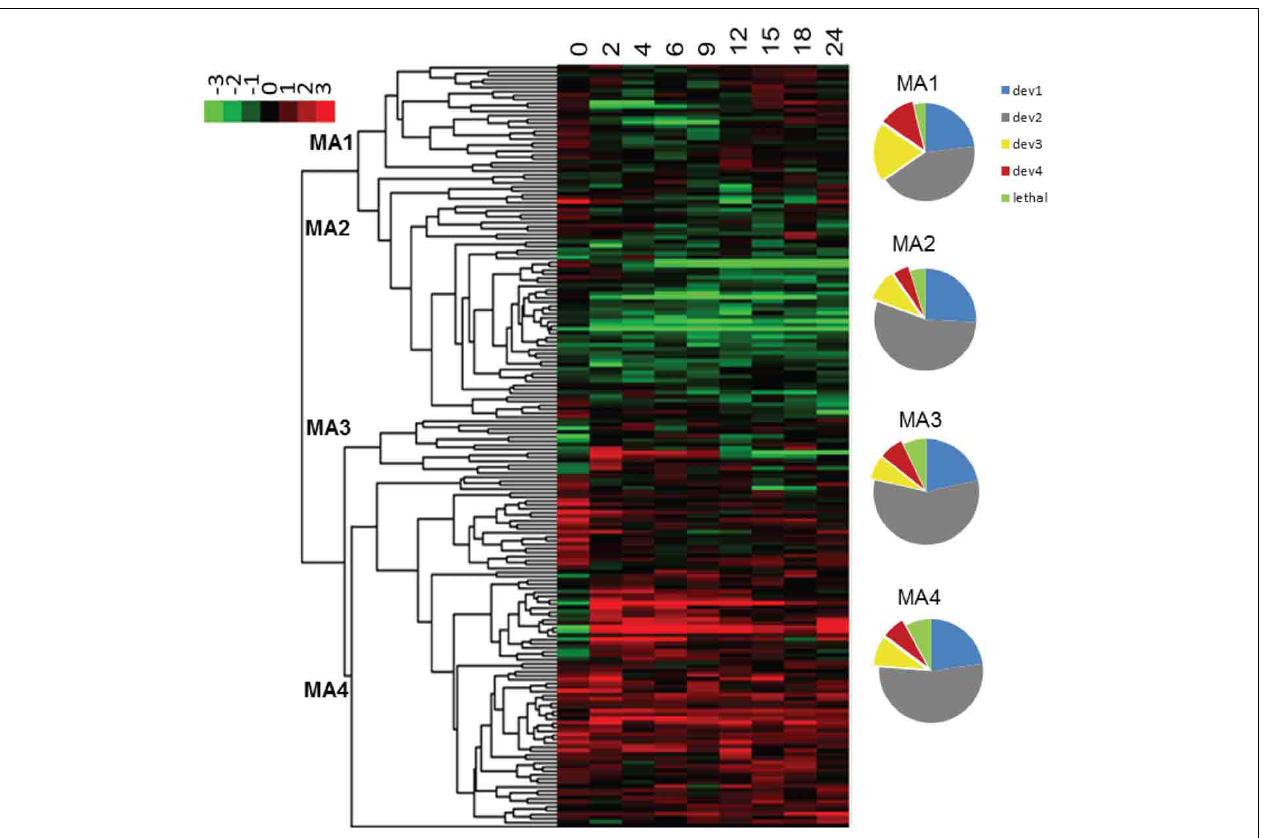
FIGURE 7 | Expression profiles of ABC transporters upon starvation. The color scheme is shown in the upper left corner. The four clusters are numbered at their nodes. The numbers at the top of the heat map represent the hours after the initiation of starvation. The pie charts on the right show